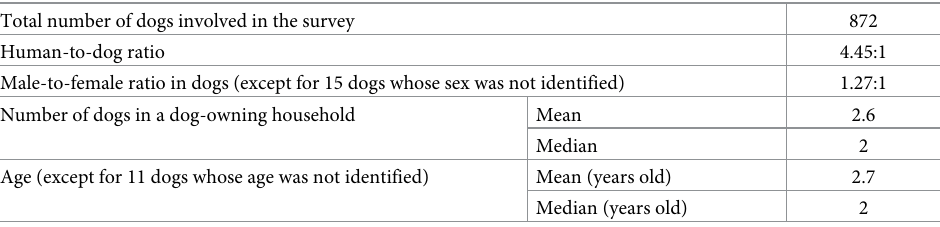
Table 3. Characteristics of the studied dog